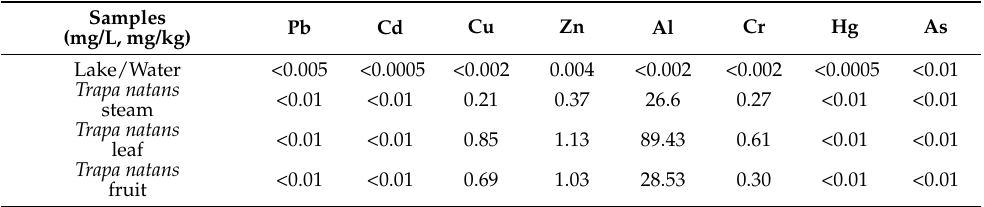
Table 3. Results of metal analysis in the water (near the settlement Vranjina), and in water chesnut (stem, leaf, fruit).